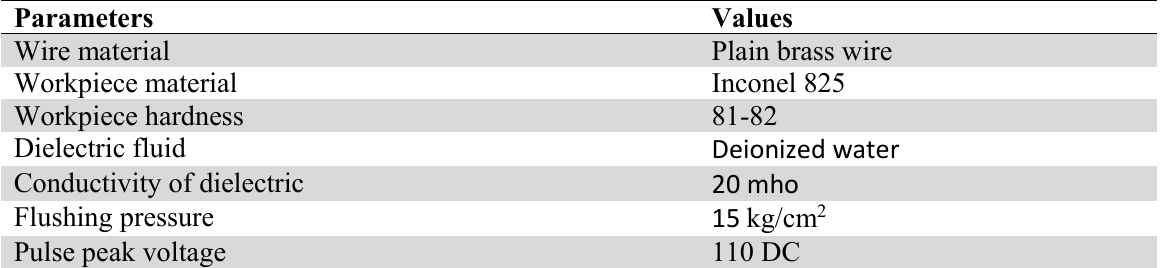
Constant parameters for wire electrical discharge machining